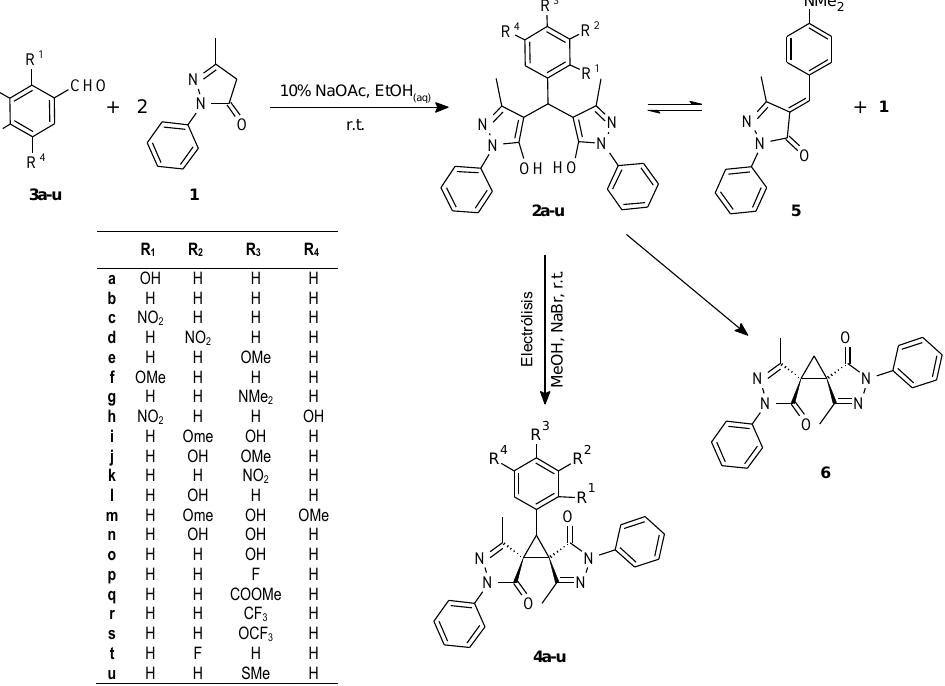
Table 1. Synthesis of bis(pyrazol-5-oles) 2 and bis(spiropyrazolone)cyclopropanes 4